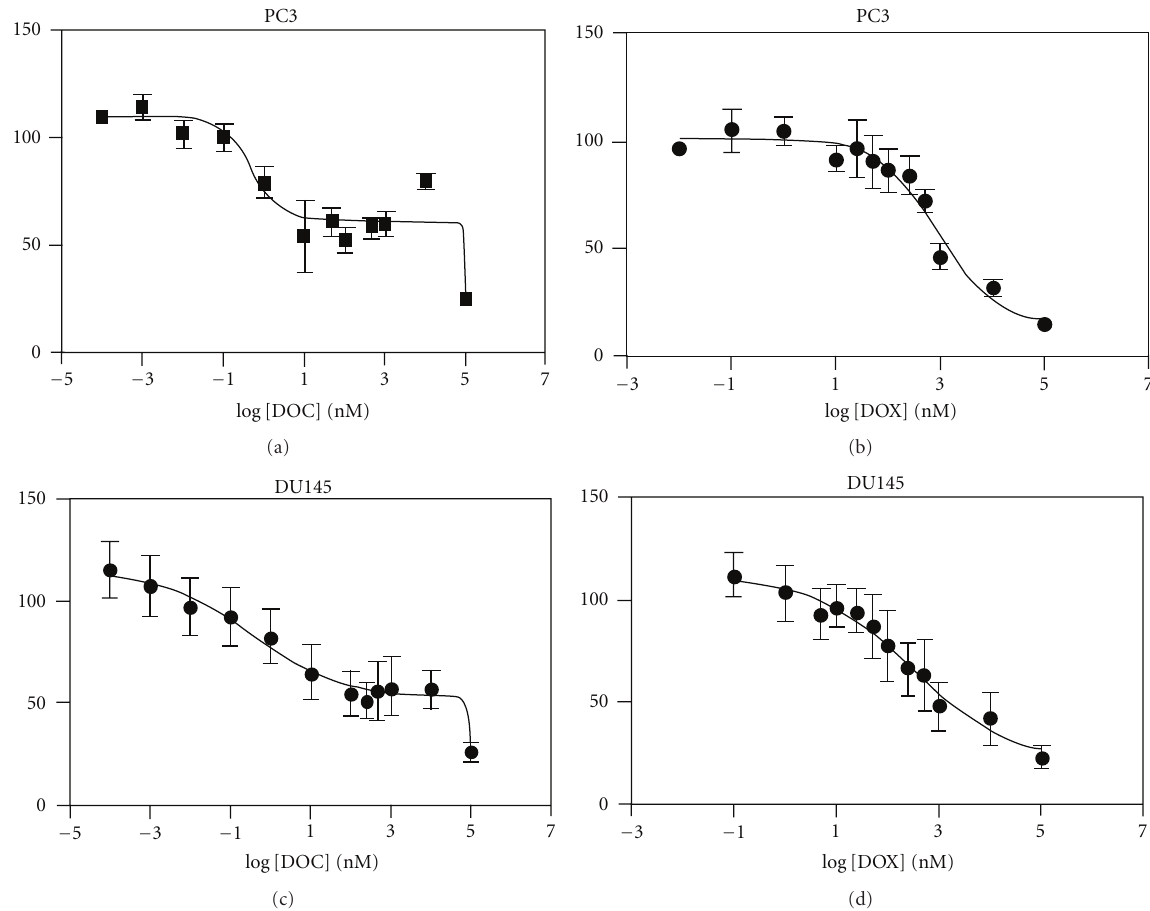
Figure 2: Dose response curves. PC3 and DU145 cells were exposed to either DOC (a) and (c) or DOX (b) and (d) for 72 hours, followed by the resazurin assay to determine cell viability (mean ± SD, n = 6).